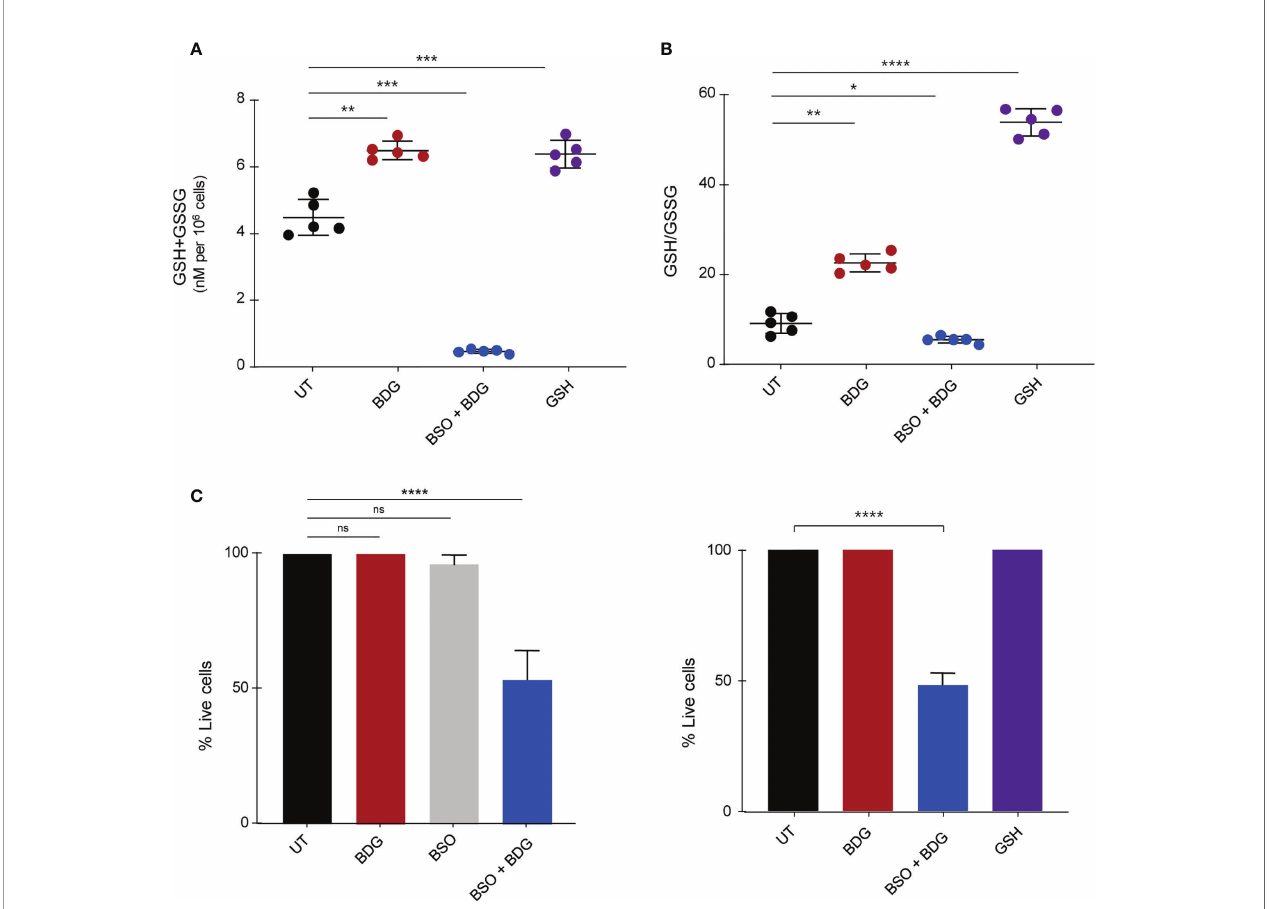
FIGURE 5 | Intracellular glutathione contributes to monocyte survival after BDG exposure. Monocytes were stimulated with BDG for 24 hours, pre-treated with BSO for 24 hours and then stimulated with BDG for 24 hours, or stimulated with GSH for 24 hours and then assessed for (A) Intracellular GSH+GSSG (total intracellular glutathione concentration), (B) GSH/GSSG (reduced to oxidized glutathione ratio), and (C) cell survival. Data are presented as median ± standard deviation of n ≥ 3 biologically independent experiments. P- values were calculated using paired one-way ANOVA with multiple comparisons. ns, not signi fi cant; * P < 0.05; **P < 0.01; *** P < 0.001; **** P <